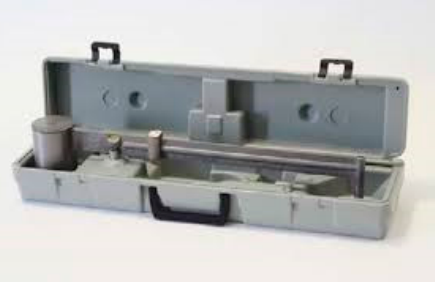
Figure 3. The used mud balance device.